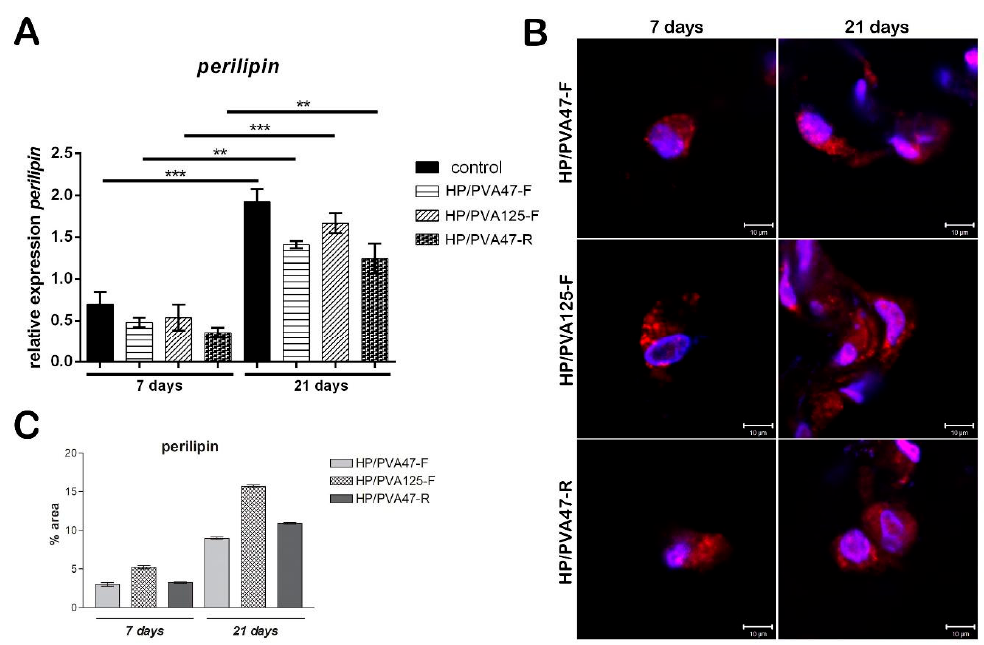
Figure 7. Evaluation of perilipin gene expression after 7 and 21 days of adipogenic differentiation ( A ); Evaluation of perilipin protein expression after 7 and 21 days of adipogenic differentiation by confocal microscopy ( B ); scale bar 10 µm; quantification of perilpin levels of protein expression ( C ).